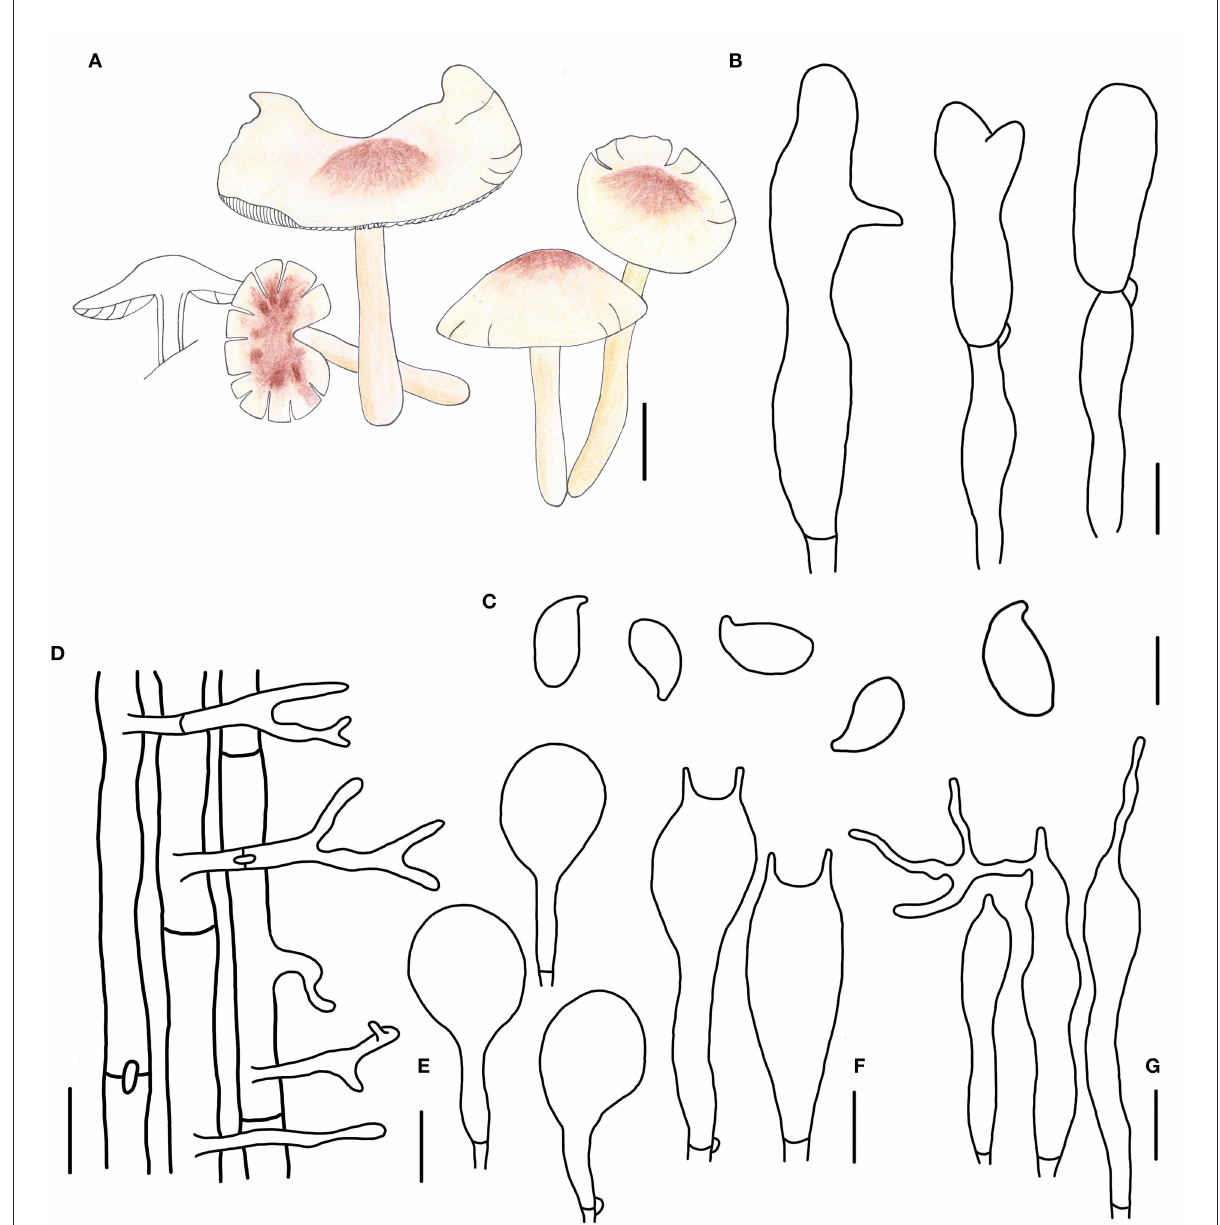
FIGURE4 Morphological characteristics of Gymnopus cystidiosus (HMJAU 60992, holotype). (A) Basidiomata; (B) Pileipellis elements; (C) Basidospores; (D) Caulocystidia; (E) Pleurocystidia; (F) Basidia; (G) Cheilocystidia; Scale bars: 1cm (A) ; 10 µ m (B,E) ; 20 µ m (D) ; 5 µ m (C,F,G) .